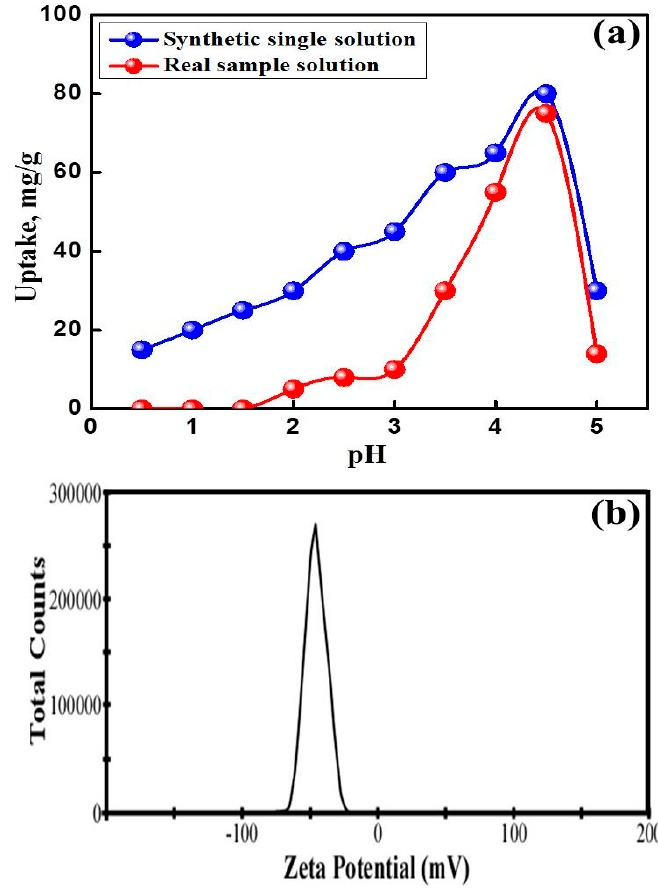
Figure 4. ( a ) Effect of initial pH on the adsorption of uranyl ions on NaZrP-CEX in single solution (initial uranyl concentration 100 mg L − 1 , NaZrP-CEX weight 20 mg, solution volume 20 mL, contact time 3 h and 25 °C) and real sample solution containing uranium ions. ( b ) Zeta potential of the mesoporous NaZrP particles.